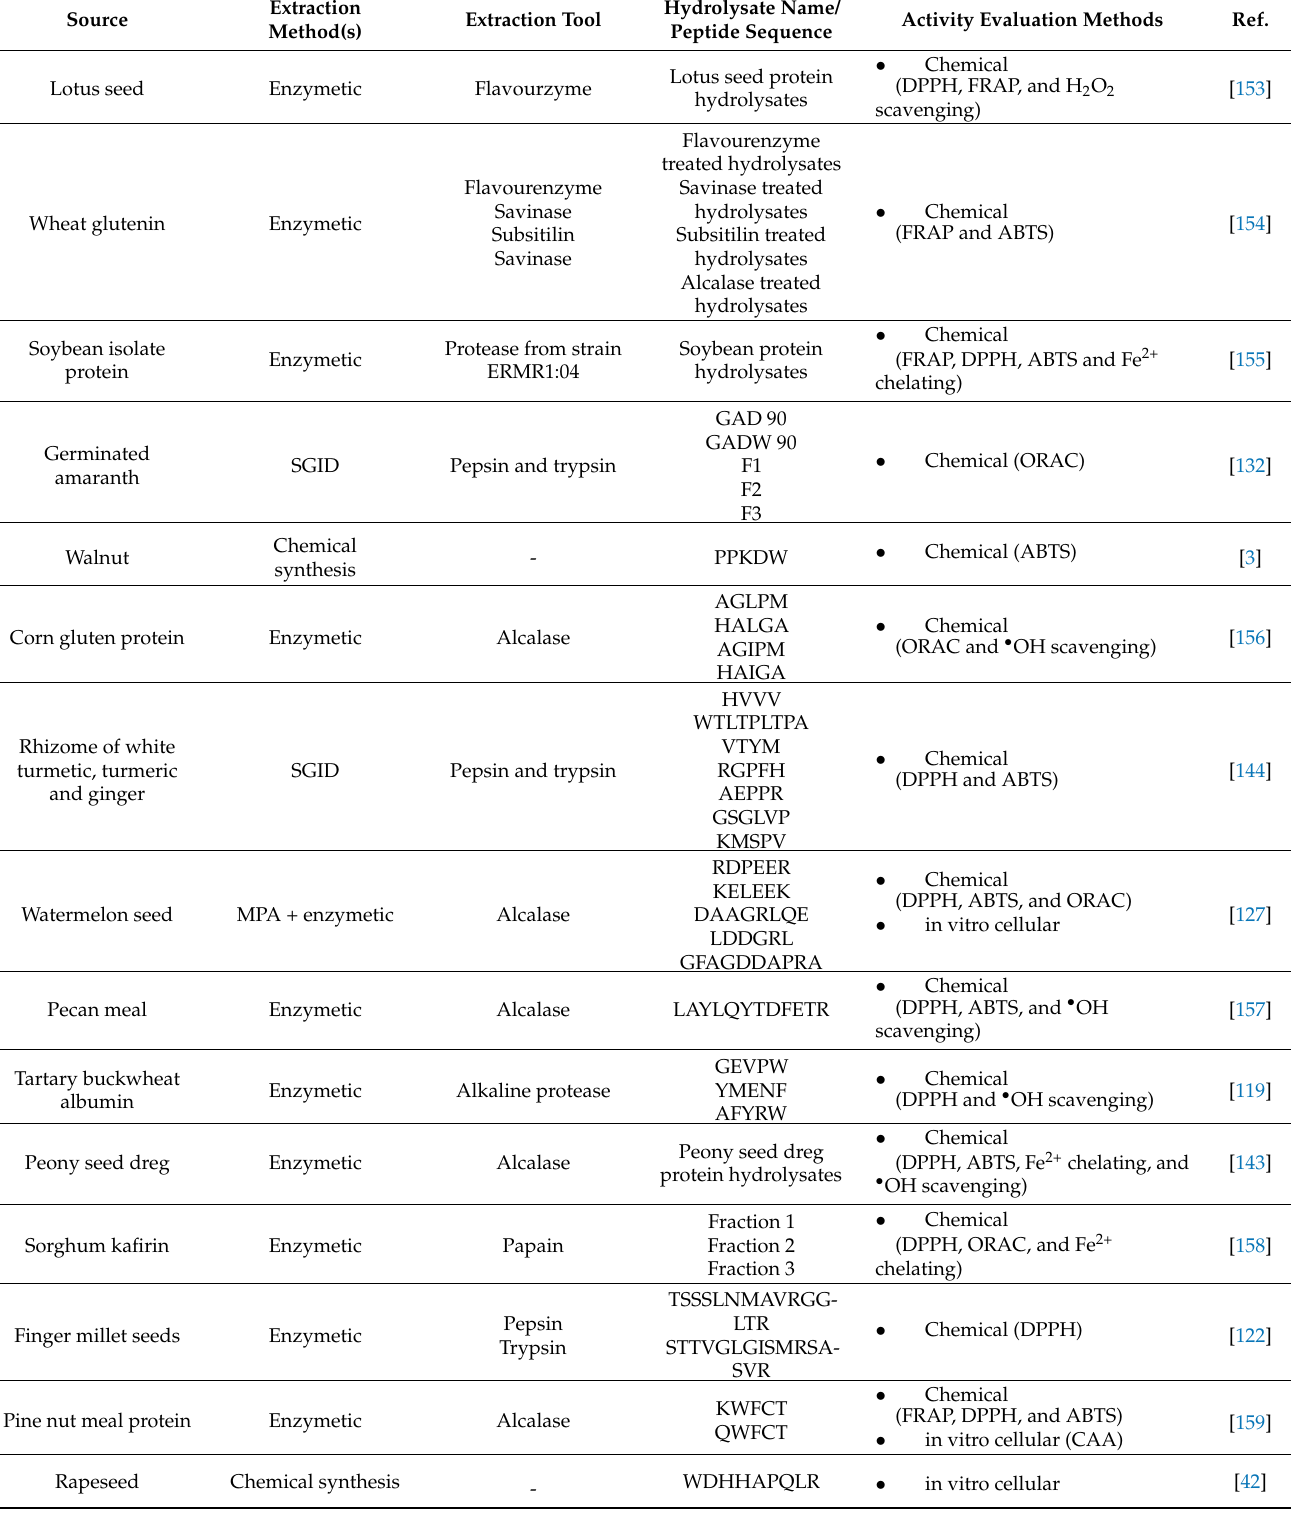
Table 3. Plant sources of antioxidative hydrolysates and